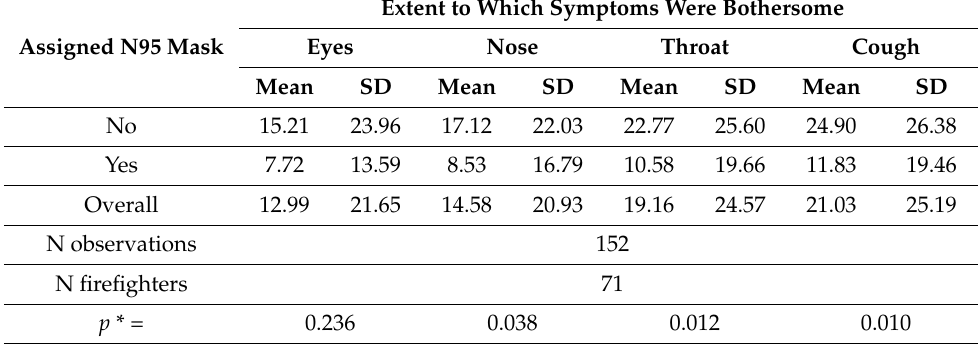
Table 3. Allocation to mask wearing by end of rotation symptoms.